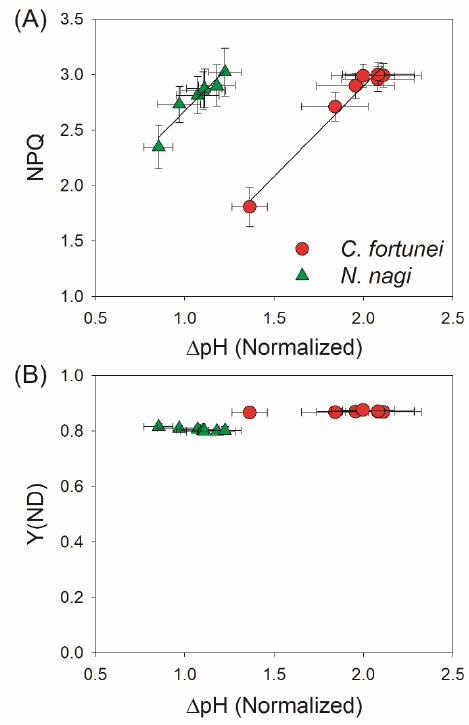
Figure 7. Changes in NPQ ( A ) and Y(ND) ( B ) as a function of ∆pH after transition from 59 to 1809 μmol photons m −2 s −1 in leaves of Cyrtomium fortune and Nageia nagi . The data are the means ± SE (n = 5).